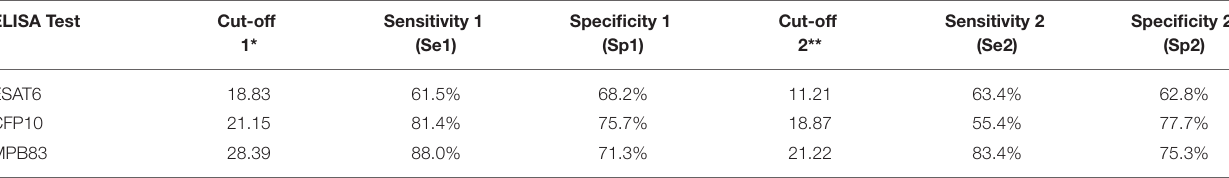
TABLE 3 | Receiver operation curve analysis: estimated cut-off value and subsequent sensitivity and specificity for each ELISA test based on the LCA predicted TB serology test outcomes. ELISA